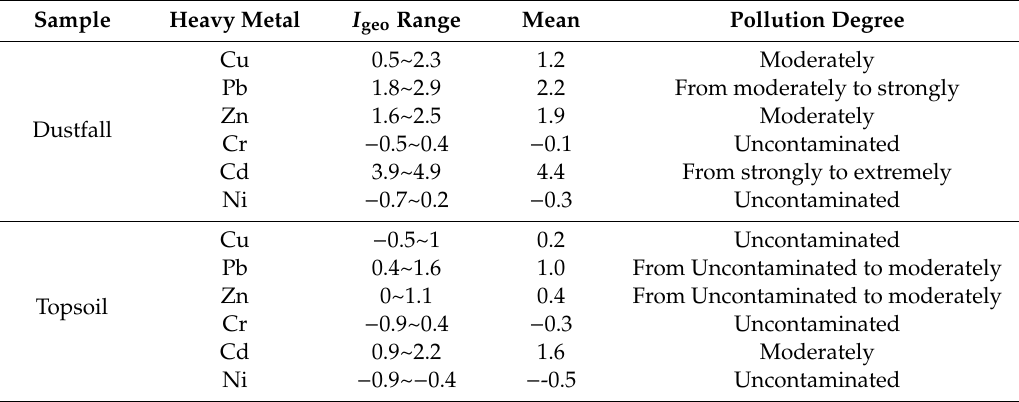
Table 6. The I geo of heavy metals in atmospheric dustfall and topsoil in